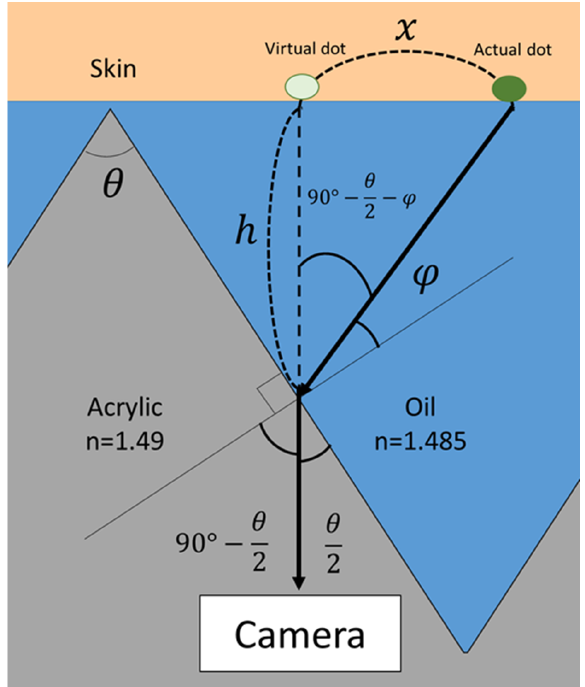
Figure 2. Overview of light refraction and the amount of optical misalignment caused by it. The refractive index of the medium, the angle of the texture, and the distance to the fingertip are defined as n , θ , and h , respectively. As temporary variables, the angle of incidence and the amount of optical deviation from the actual dot are set to φ and x , respectively.